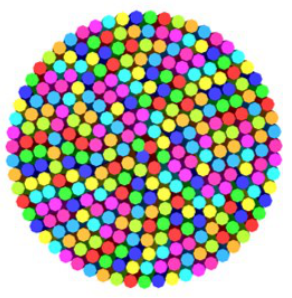
Figure 17. Cross section of the full yarn model.